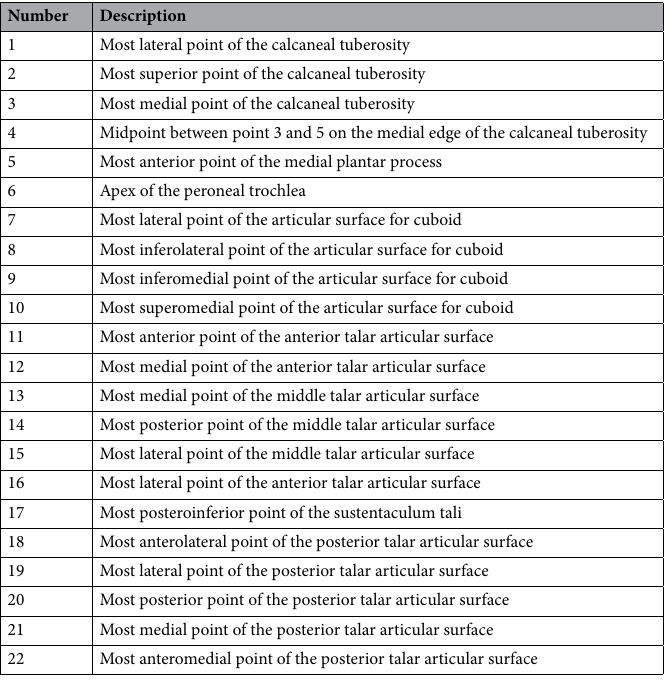
Figure 1. Landmarks used in the present study. Twenty-two anatomical landmarks (red) and 534 semi- landmarks (black) were defined on a representative chimpanzee calcaneal specimen chosen as a template. Wireframes connecting primary landmarks were drawn to visualize shape variations. ( a ) Medial view, ( b ) Superior view, ( c ) Inferior view, ( d ) Anterior view, ( e ) Posterior view.